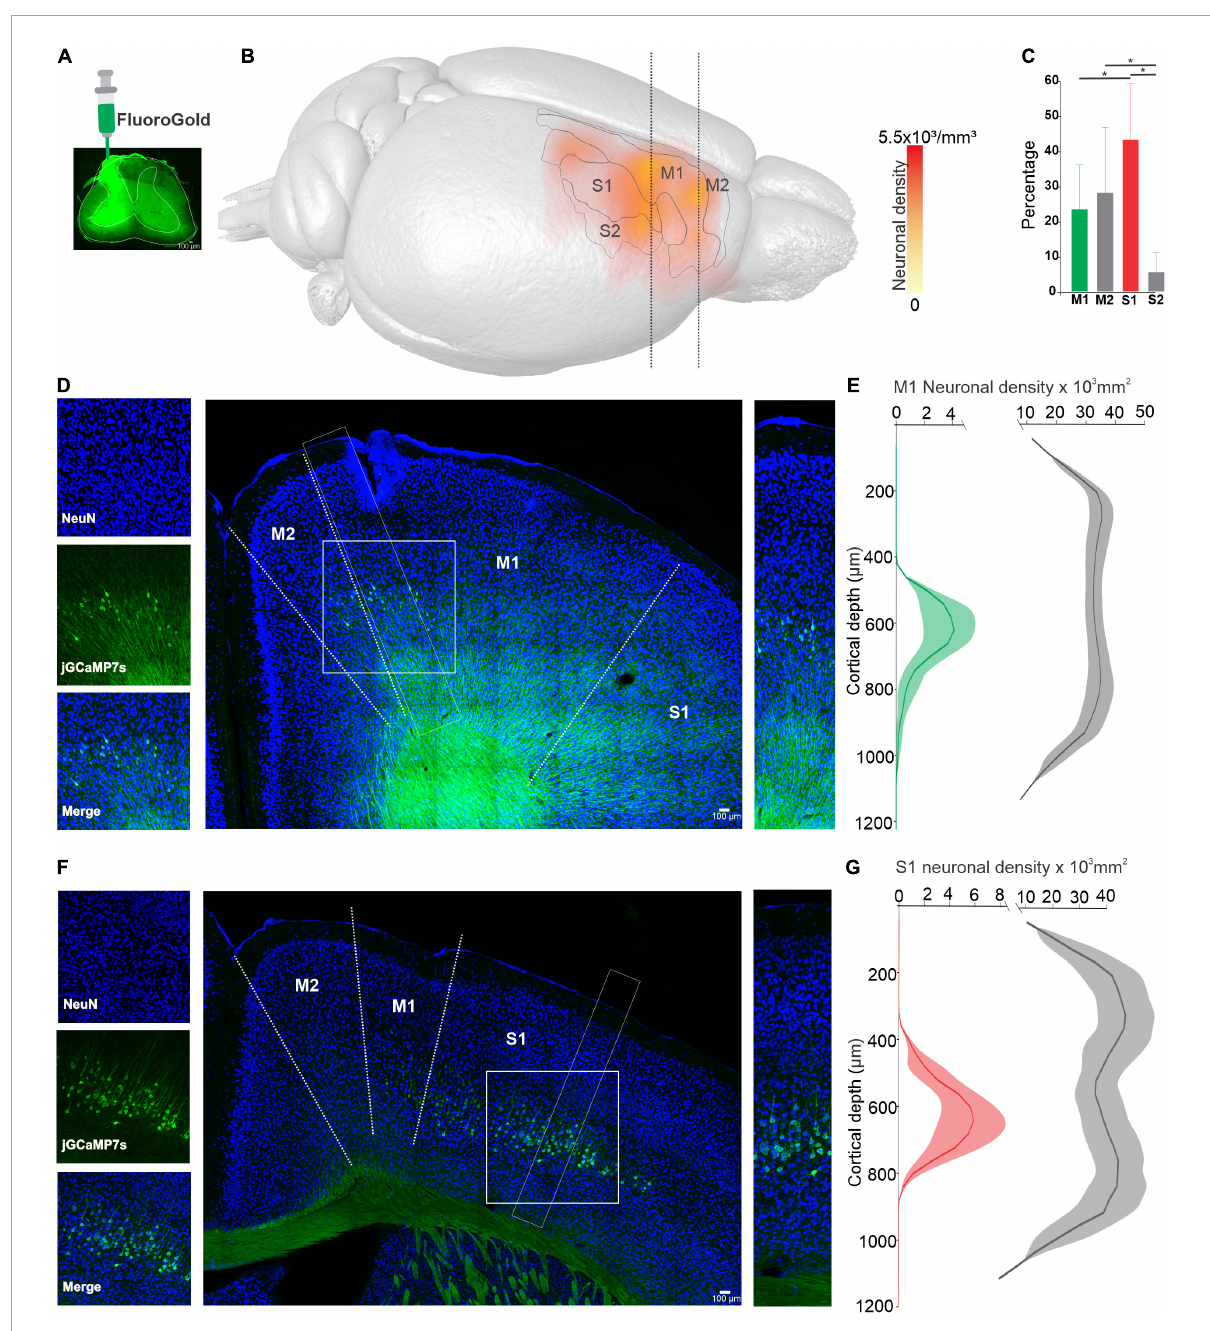
FIGURE1 Distribution of corticospinal (CSp) neurons in sensorimotor cortical areas. (A) , Injection site of Fluorogold (FG) into cervical segments of the spinal cord (C4–C5). (B) , Average neuronal density map showing the distribution of CSp labeled neurons obtained from three animals. CSp labeled cells identified in the histological images were superimposed onto magnetic resonance image (MRI) volume (see methods). (C) , Percentage number of neurons (mean ± SD labeled in four areas of sensorimotor cortex (S1, M1, M2, and S2) defined by the MRI atlas. Significant differences are indicated with upper lines (* p < 0.05, One-way ANOVA). (D) , Coronal sections contralateral to the injection site showing CSp cells (green) and Neuronal Nuclear Antigen (NeuN) labeled cells (blue). Cropped images on the left and right show CSp and NeuN positive cells of the areas outlined by white dashed lines. (E) , Average density profiles computed in three consecutive slices for three experiments along the vertical axes of CSp neurons (mean green line, shadow SE) and NeuN labeled neurons (mean gray line, shadow SE). (F,G) , The same as (D,E) but for the S1 cortex. The scale of the cropped images (D,F) is the same as their respective neuronal density